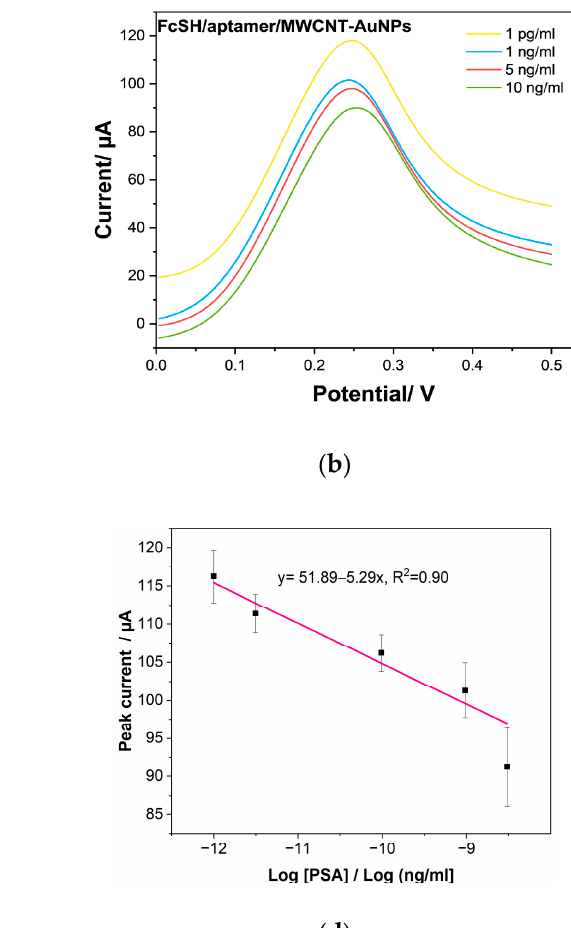
Table 2. Comparison of suggested PSA biosensors’ performance with other aptamer-based biosen- sors.